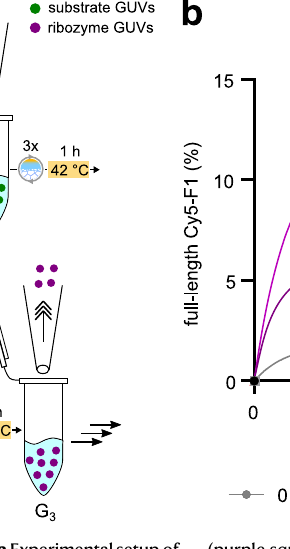
(purple squares), or 2 µ M (pink triangles) unlabelled F1 ribozyme as initial seed, 10 µ M Hyper-A with 2.5 µ M Cy5-A, or 15 µ M B were combined in 1:1:1 ratio as shown in Fig. 2a. PAGE samples were taken before (G 0 ) and after (G 1 ) FT-induced content mixing and self-replication (42°C for 1h). In all further generations, PAGE samples were taken after 1:1 serial dilution of the previous generation with fresh substrate GUVs followed by three FT-cycles and the 1h incubation at 42°C as shown in a ). Data were fi tted with a singleexponential for descriptive reasons. Every data point represents an independent experimental